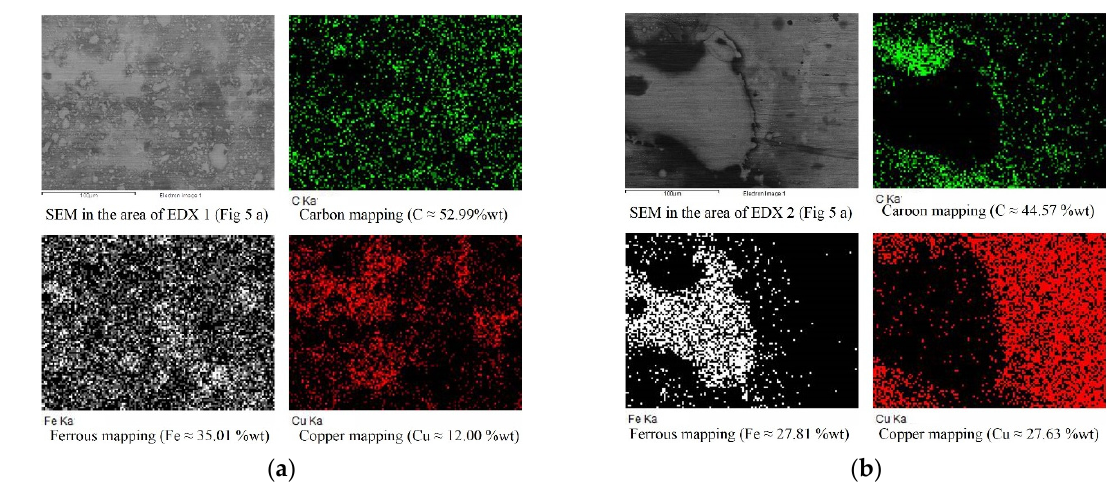
Figure 12. Analysis of alloy element mapping on the conventional electrode (CE). ( a ) Elemental mapping in the area of EDX 1; ( b ) elemental mapping in the area of EDX 2.